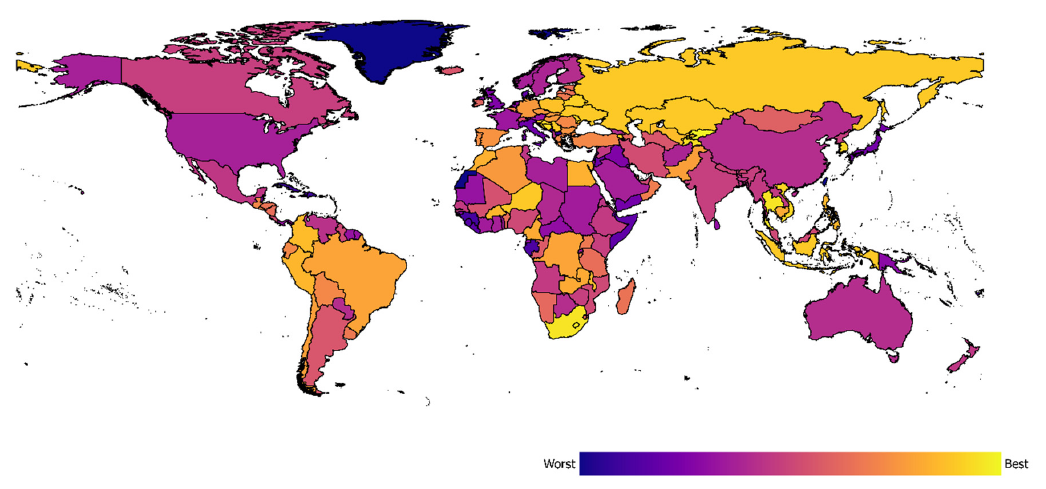
Figure 5. Global view on the Cost dimension.